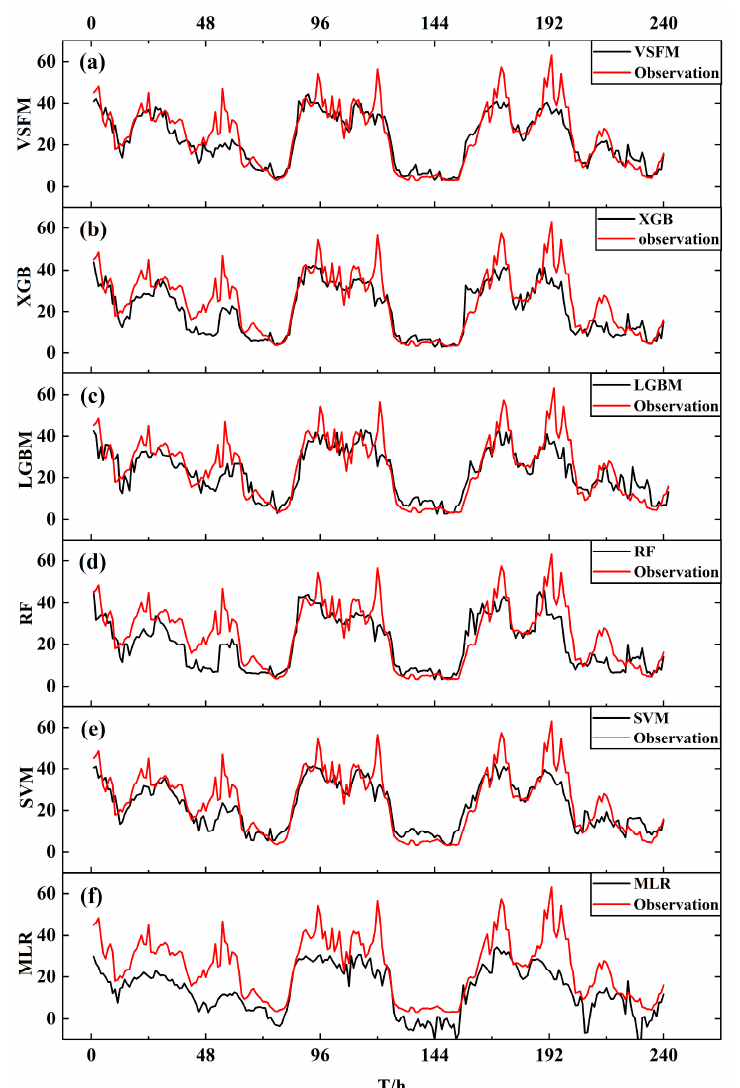
Figure 5. The prediction effect of each model in 2020_Spring. ( a – f ) show the prediction effects of the VSFM, XGBoost, LightGBM, RF, SVM, and MLR, respectively.